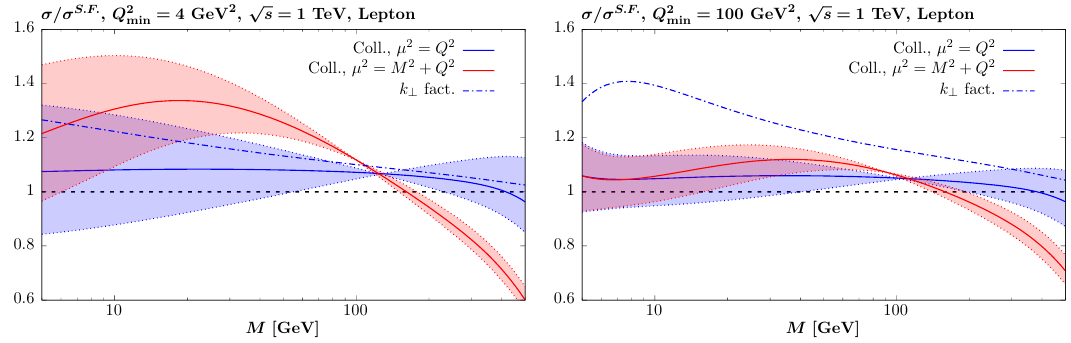
Figure 3 . Ratio of the cross sections for heavy lepton (with mass M ) production calculated within the approximate NLO collinear approach (3.13), to the structure function result (3.4). The left (right) (cid:12)gures correspond to the case that a cut of Q 2 > 4 (100) GeV 2 is placed. Results for di(cid:11)erent choices of factorization scale are shown, with the band corresponding to variations in the factorization/renormalization scales as above. The prediction within the k ? factorization approach is also